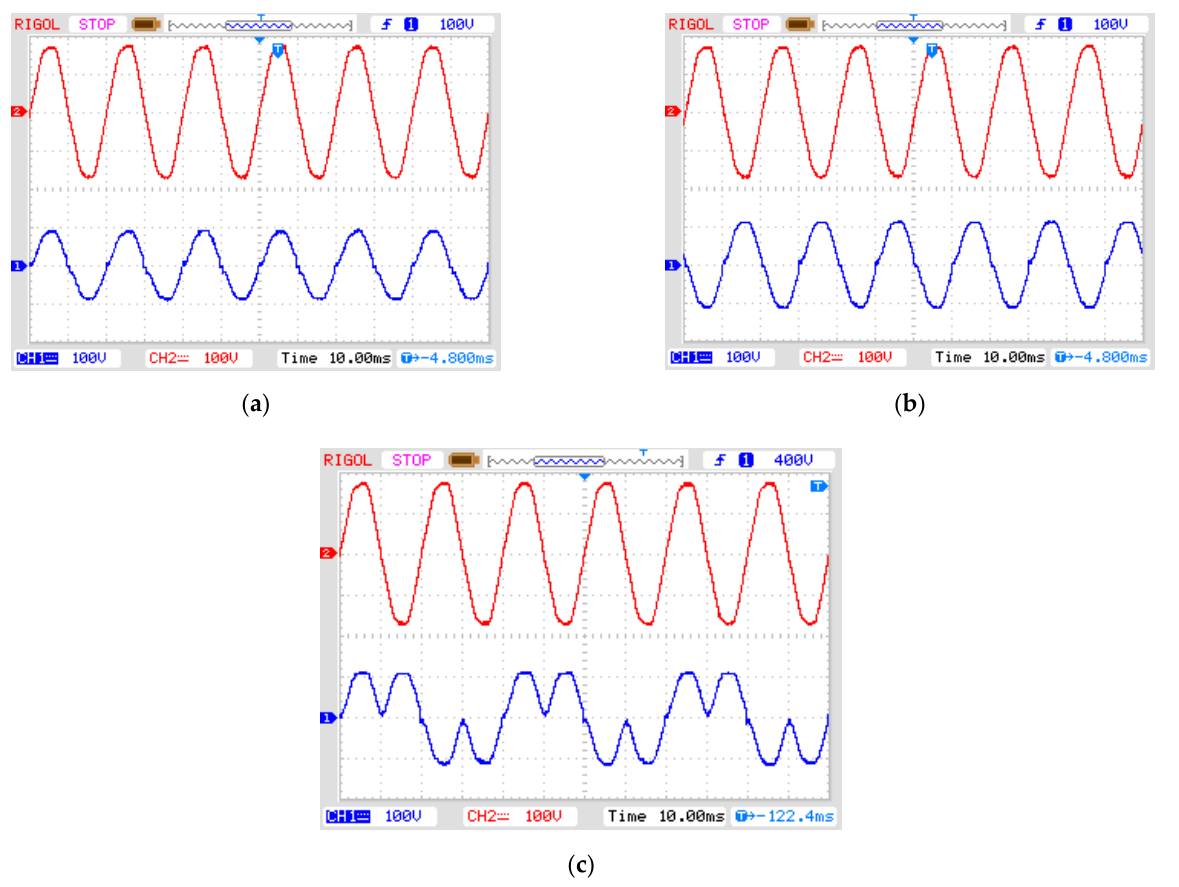
Figure 8. Recording of output waveforms (blue) with respect to input voltage (red) with a voltage gain of 0.6: ( a ) voltage in-phase form; ( b ) voltage out-of-phase form; ( c ) frequency regulation form.